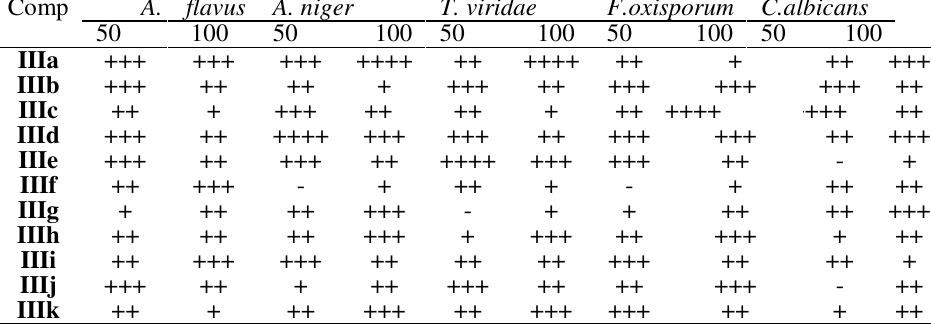
Table 4. Antifungal activity of the synthesized III(a-k) against various fungi at two different concentrations